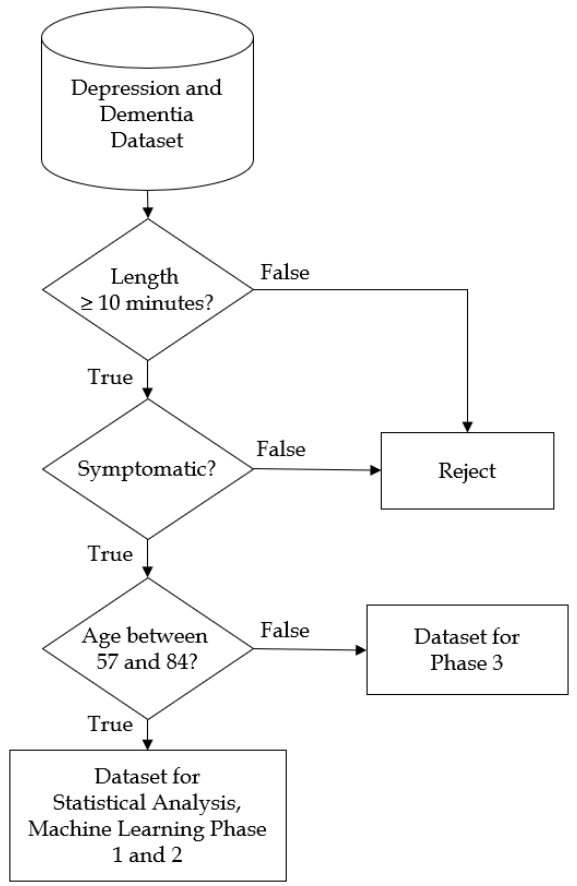
Figure 2. Flowchart of dataset